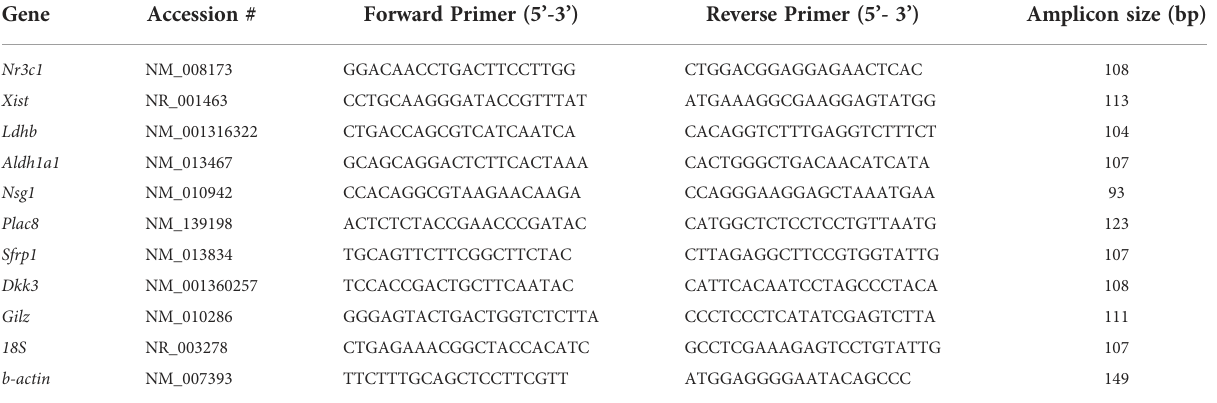
TABLE 1 GenBank accession numbers, primer sequences and amplicon sizes of genes used for qRT-PCR